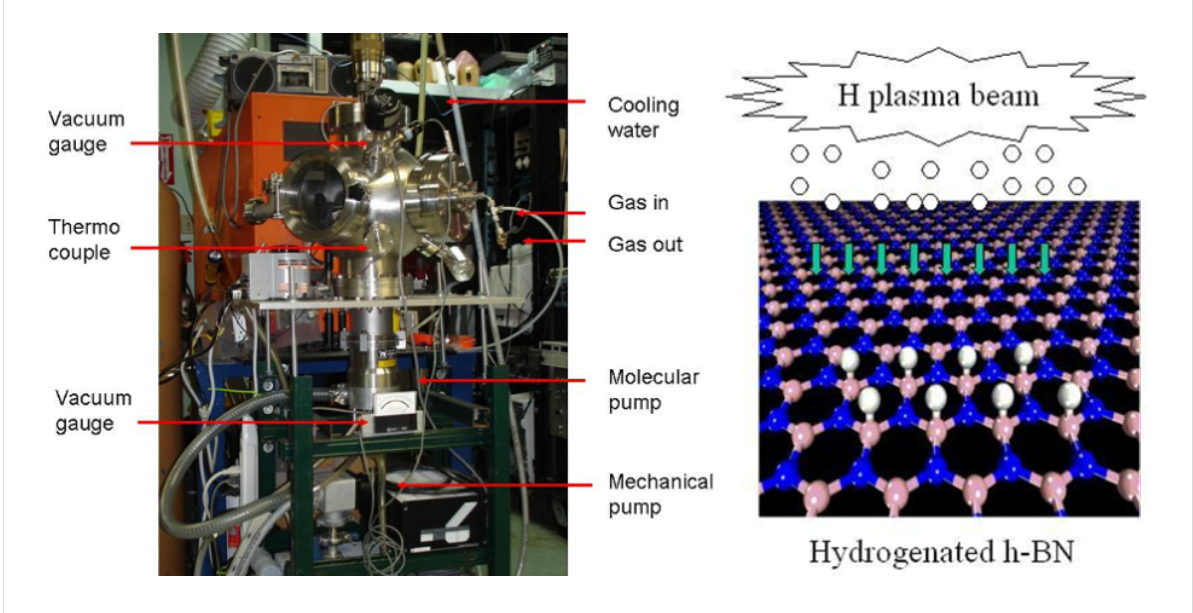
Figure 6: (a) Experimental set up for H plasma functionalization of the BNNSs, and (b) schematic diagram for formation of hydrogenated BNNS.